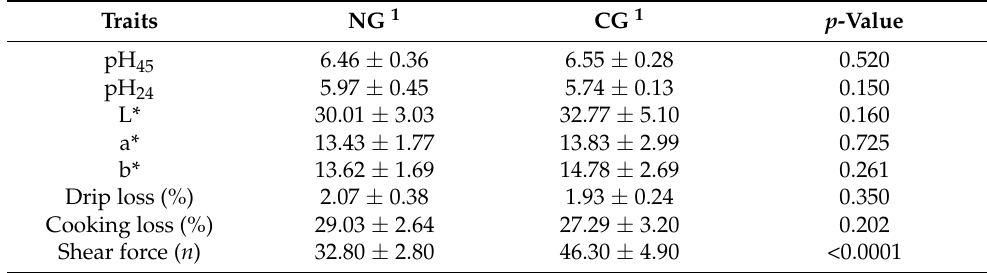
Table 2. Meat quality characteristics in Longissimus thoracis m. of Southern Thai native goats (NG) and Three-way crossbred goats